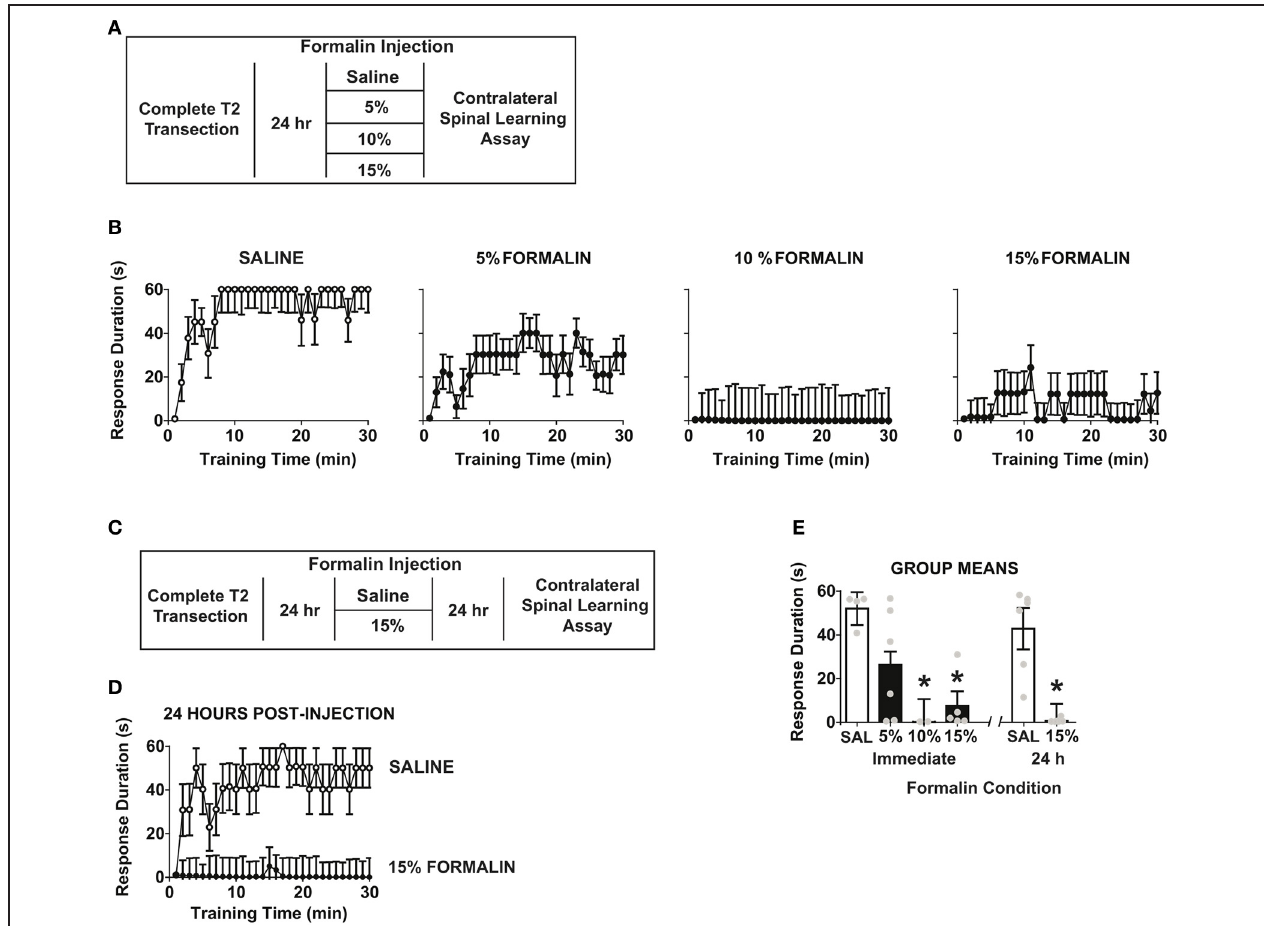
FIGURE 5 | Intradermal formalin produces contralateral impairments in spinal learning. (A) Experimental design used to test immediate dose-response characteristics of formalin concentration on spinal learning potential. (B) Concentration-dependent impairment in spinal learning contralateral to formalin injection (0%, n = 4; 5%, n = 6; 10%, n = 2; 15%, n = 5; the numbers of subjects is supported by statistical power analysis, partial eta squared = 0.58, power = 0.89). Mixed repeated measures ANOVA revealed a significant effect of time, F ( 29 , 377 ) = 2 . 46, p < 0 . 05, and formalin concentration, F ( 3 , 13 ) = 6 . 15, p < 0 . 05. Tukey’s post-hoc test revealed that 10% and 15% formalin significantly impaired spinal cord learning relative to